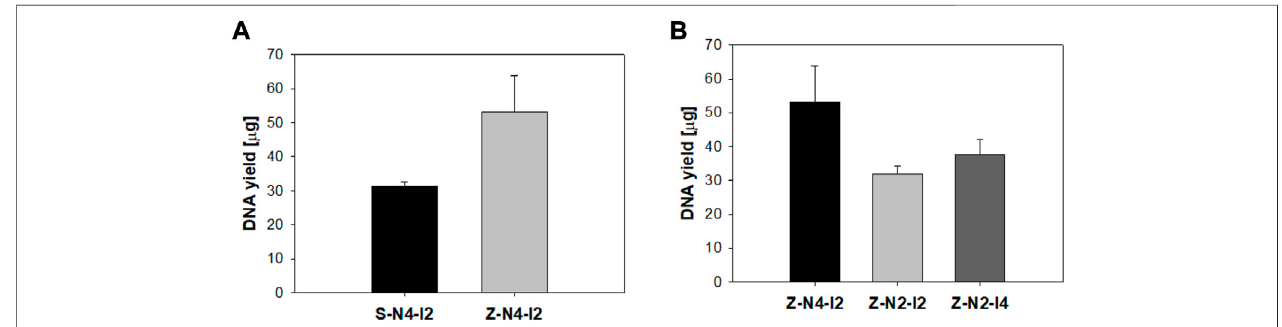
Frontiers in Bioengineering and Biotechnology |